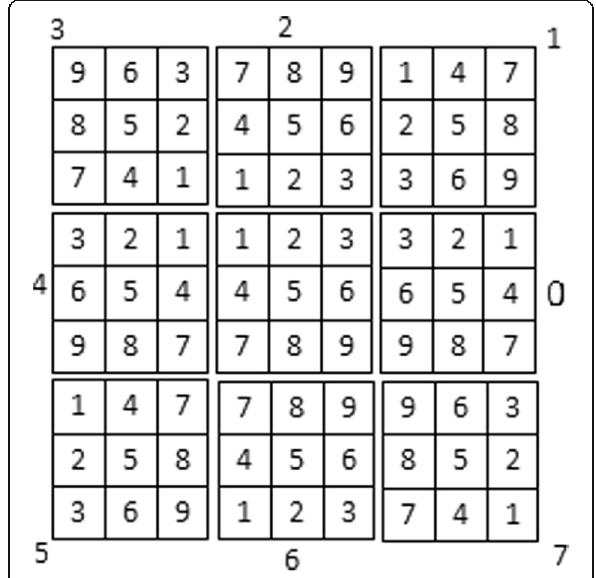
Fig. 4 Symmetric patch in eight directions